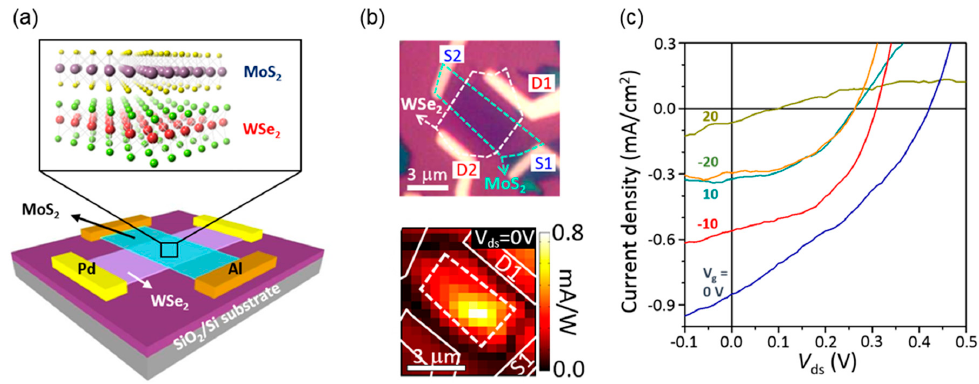
Figure 6. Gate ‐ tunable photovoltaic response in an atomically thin p ‐ n heterojunction. ( a ) Schematic diagram of a vdW ‐ stacked MoS 2 /WSe 2 heterojunction device with lateral metal contacts; ( b ) Optical image of the fabricated device (top) and photocurrent map of the device for V ds = 0 V and 532 nm laser excitation (bottom). The junction area and metal electrodes are indicated by dashed and solid lines, respectively; ( c ) Photoresponse characteristics at various gate voltages under white ‐ light illumination.